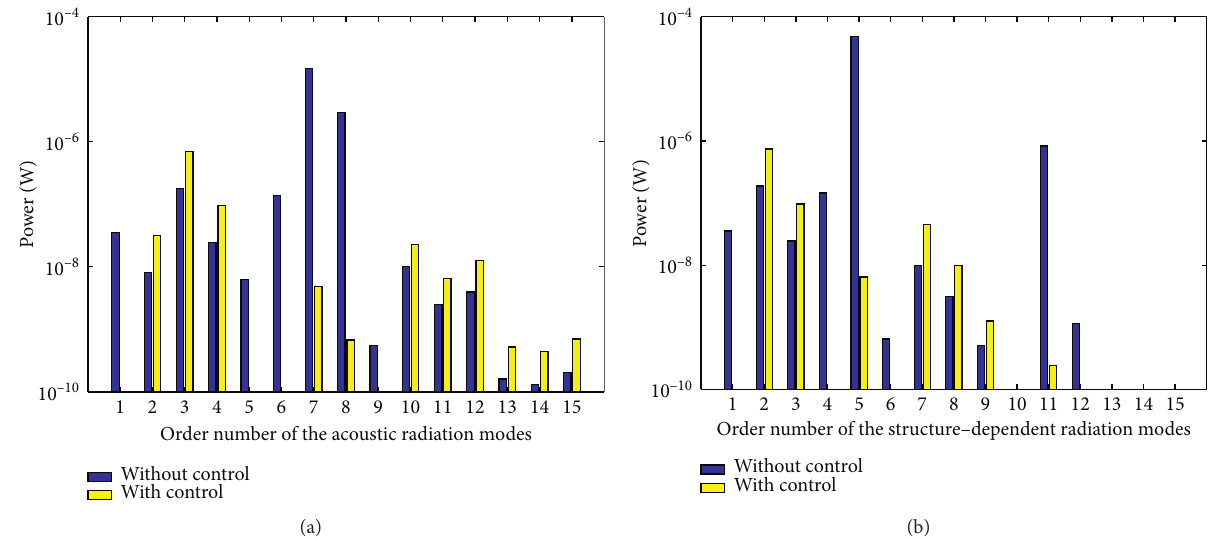
Figure 8: Sound power of the a -modes and s -modes at resonance frequency (588 Hz). (a) Sound power of the a -modes. (b) Sound power of the s